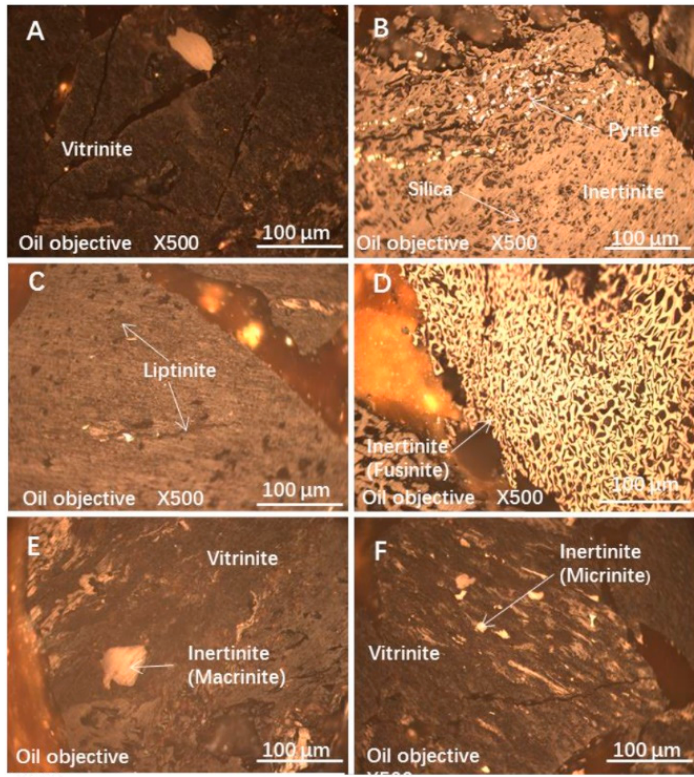
Figure 3. The images of maceral characteristics of raw coal: ( A ) Image of fractures of vitrinite; ( B ) Image of minerals embedded in the inertinite; ( C ) Image of the liptinite embedded in the vitrinite; ( D ) Image of the characteristics of pore structure in inertinite; ( E ) Image of inertinite embedded in the vitrinite; and ( F ) Image of inertinite embedded in the vitrinite.